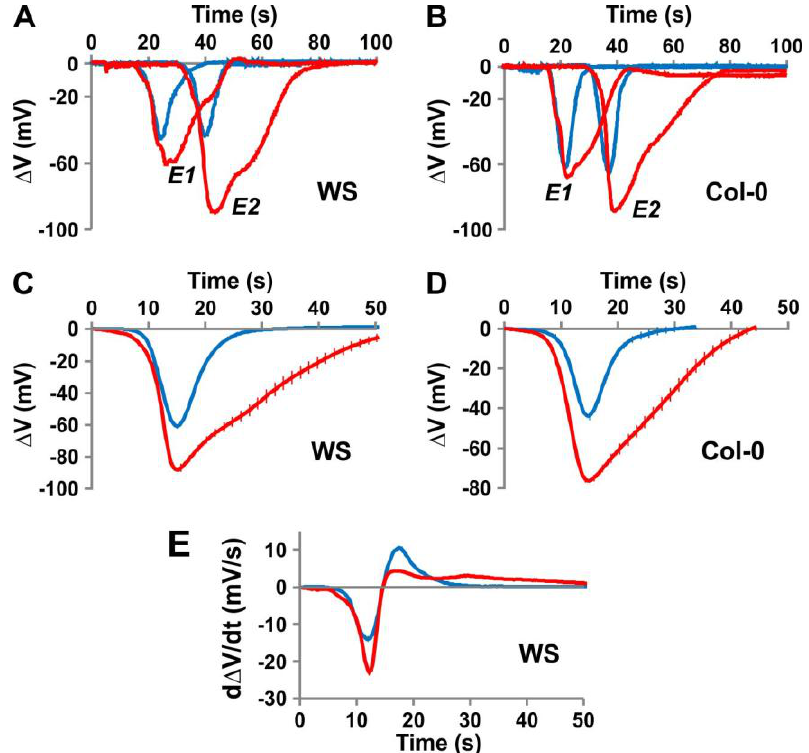
Figure 3. Dynamic characteristics of action potentials in wildtype compared to gork knockout mutants. ( A , B ). Time-course of typical APs (voltage as a function of time) recorded at electrodes E1 and E2 in WS wildtype (( A ), blue) compared to that of the WS gork knockout (( A ), red) and the Col-0 wildtype (( B ), blue) compared to that of the gork knockout in the Col-0 background (( B ), red). Zero time: start of the 5-s electrical stimulation (Figure 1A). ( C ) Time-course of averaged APs from the E2 recording electrode for the gork knockout mutant in the WS background (red) and the WS wildtype (blue) ( n = 25). ( D ) Time-course of averaged APs from the E2 recording electrode for the gork knockout mutant in the Col-0 background (red) and the wildtype Col-0 (blue) ( n = 25). ( E ) Time-course of averaged AP derivatives (dΔ V /d t as a function of time) from the E2 recording electrode for the gork knockout mutant in the WS background (red) and the wildtype WS (blue) ( n = 25).